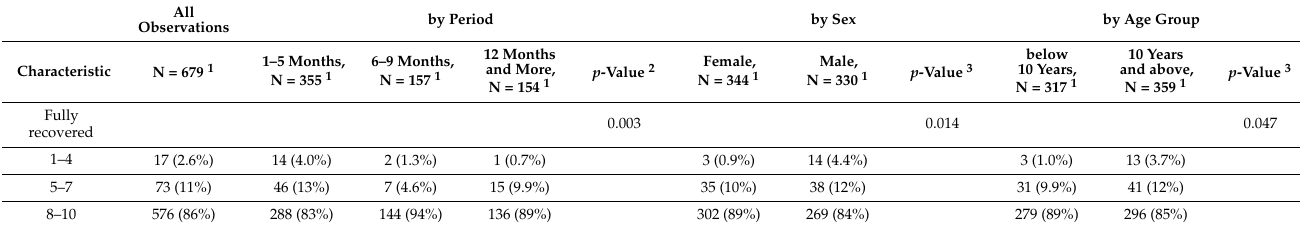
Table 4. Self-reported recovery rates according to time of follow-up, sex and age.